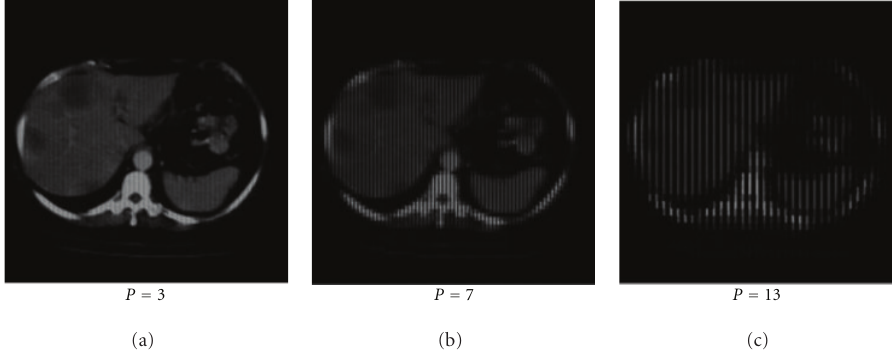
Figure 5: Ridgelet transform for real CT images at block sizes (3, 7, and 13).